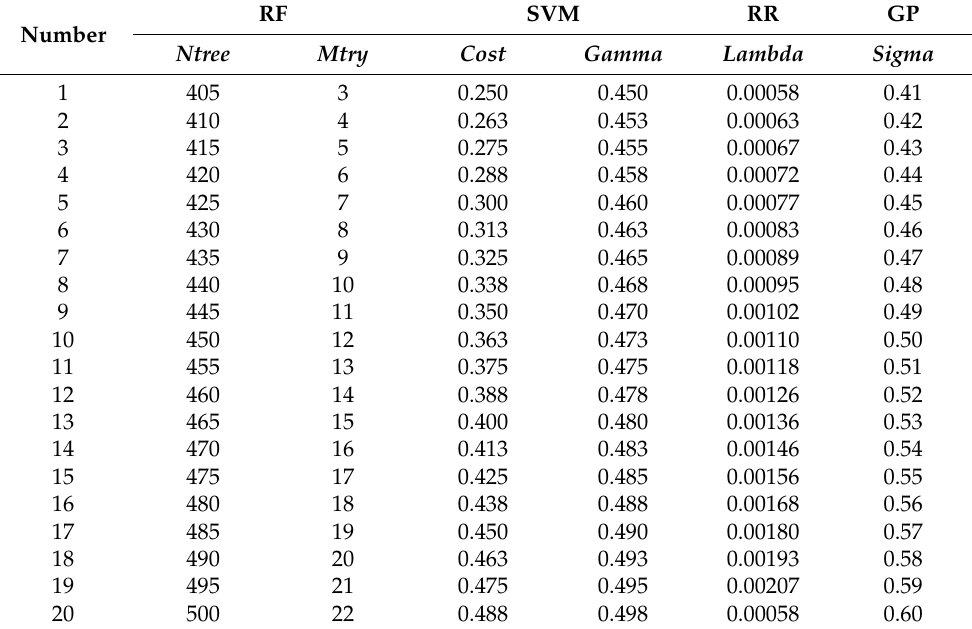
Table 4. Candidate hyperparameters of each machine learning